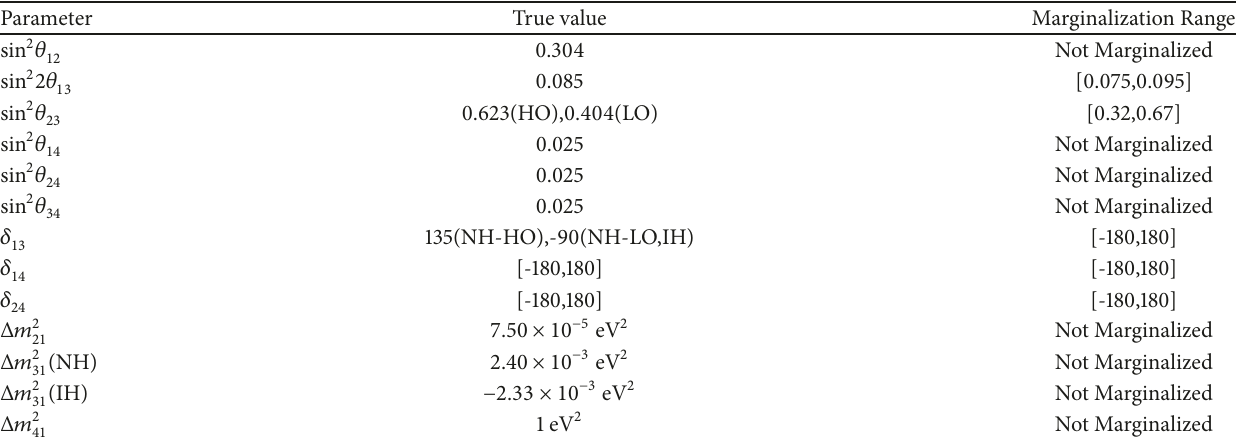
Table 3: Oscillation parameters considered in numerical analysis. The sin 2 𝜃 23 and 𝛿 13 are taken from latest NO ] A results [35].